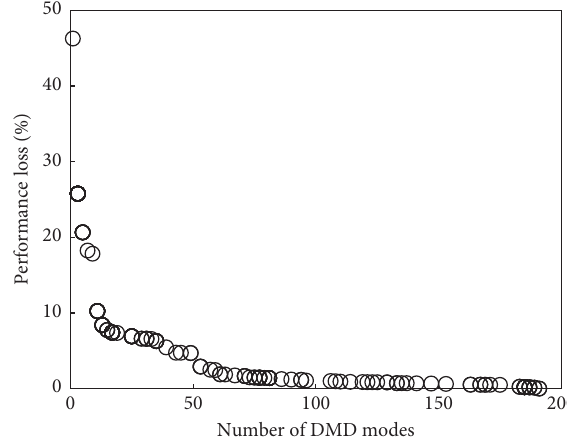
Figure 5: Performance loss with the number of retained DMD modes resulting from SPDMD for the 200hPa